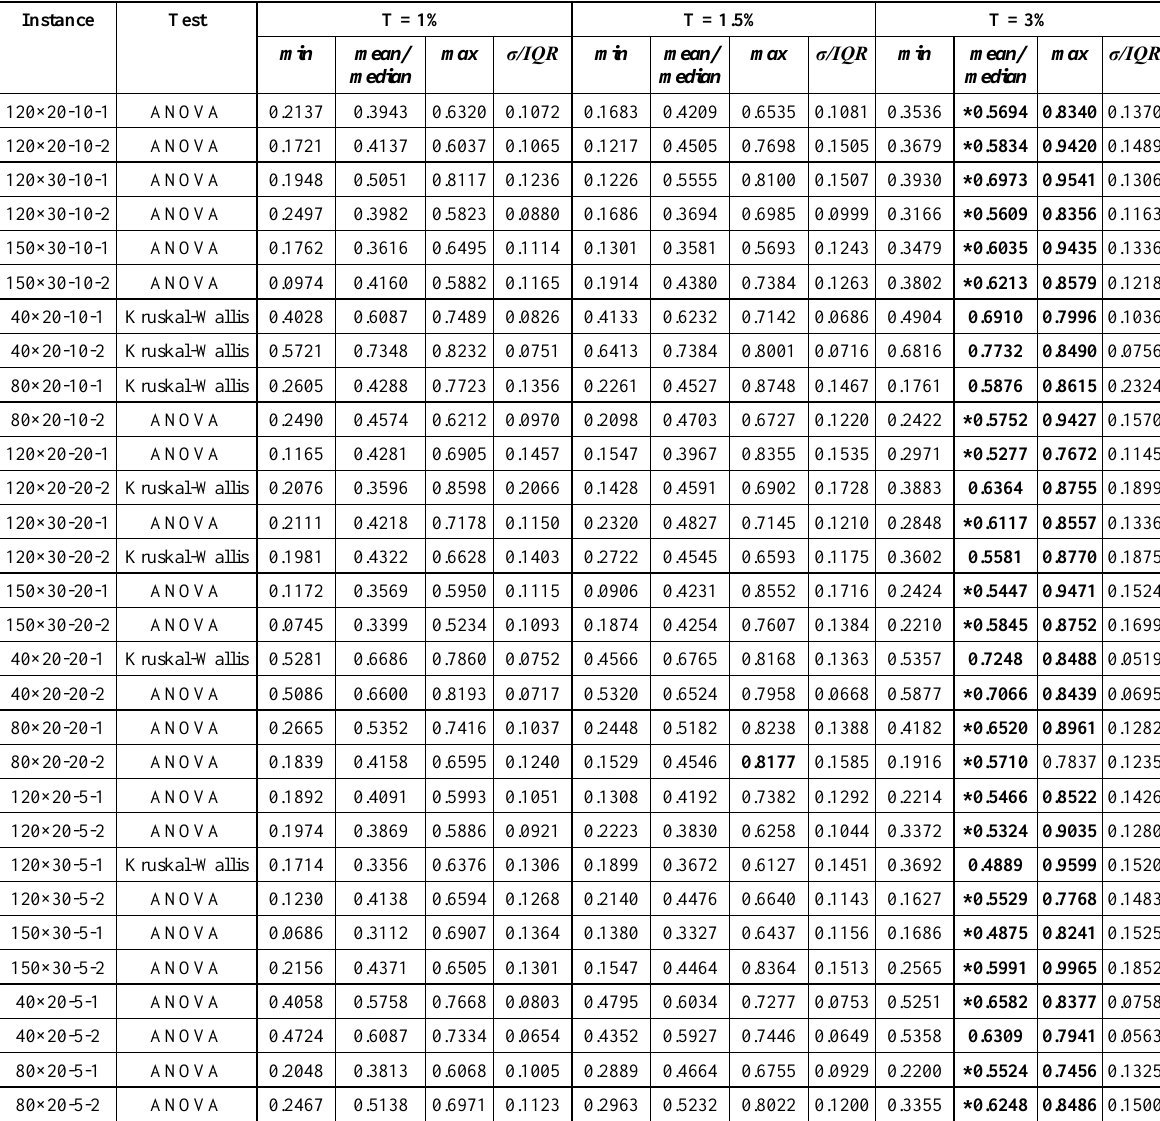
Table 2 . Results of the RHV metric of each